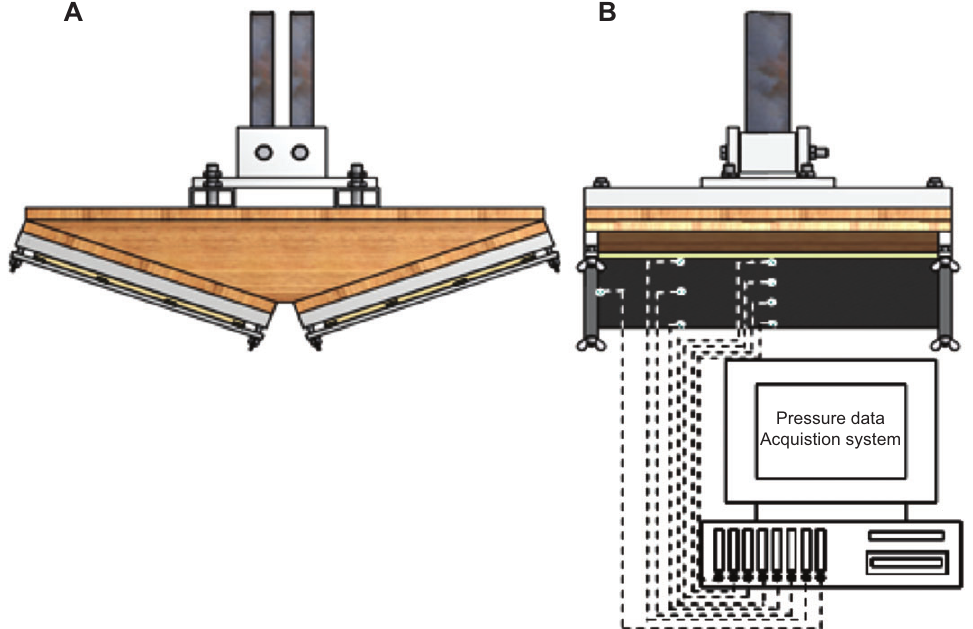
Figure 2 Wave slamming setup commonly used under drop testing with flat panels symmetrically mounted on each side.